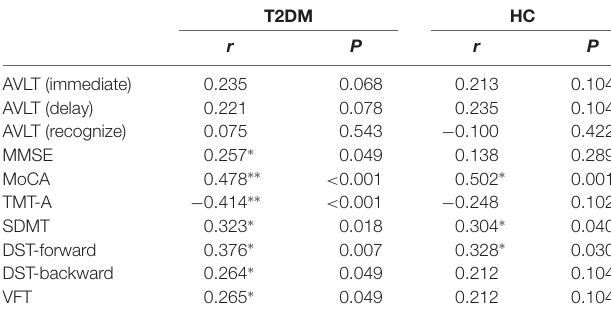
TABLE 3 | Correlation analysis of CSIT-OI scores and cognitive test